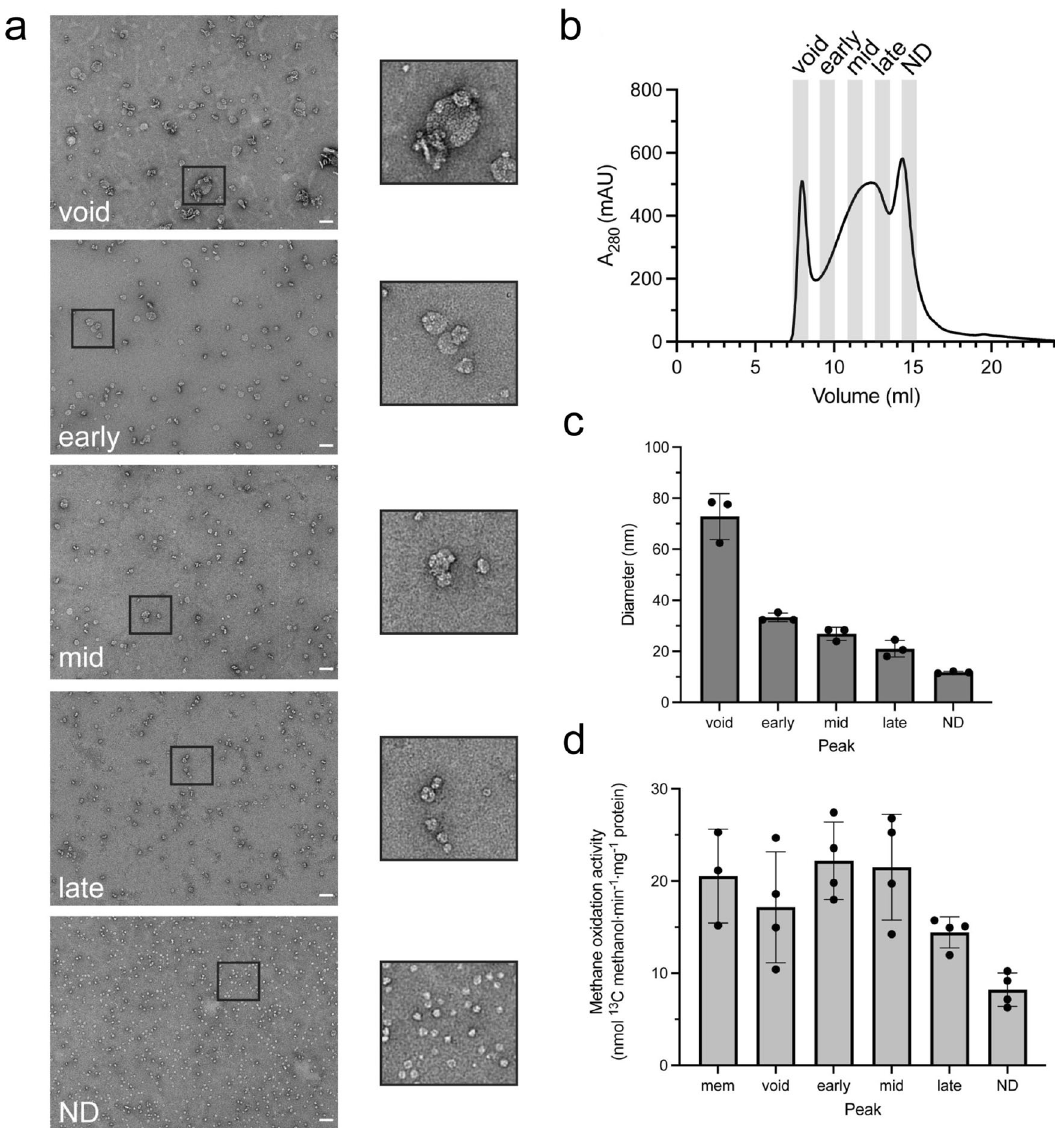
Fig. 3 | Methane oxidation by pMMO reconstituted in native lipid nanodiscs. a Representative images and enlarged views of the boxed area from elution frac- tions of pMMO nanodiscs separated on a Superose 6 size-exclusion column. Nanodiscs were generated using a ratio of 1:2:120 pMMO:MSP1E3D1:lipid. Similar micrographs were obtained in three independent experiments. b The elution pro fi leofpMMOnanodiscsize-exclusioncolumn.Thefractionsthatwerecollected are indicated. c Size distribution of pMMO nanodiscs measured by dynamic light